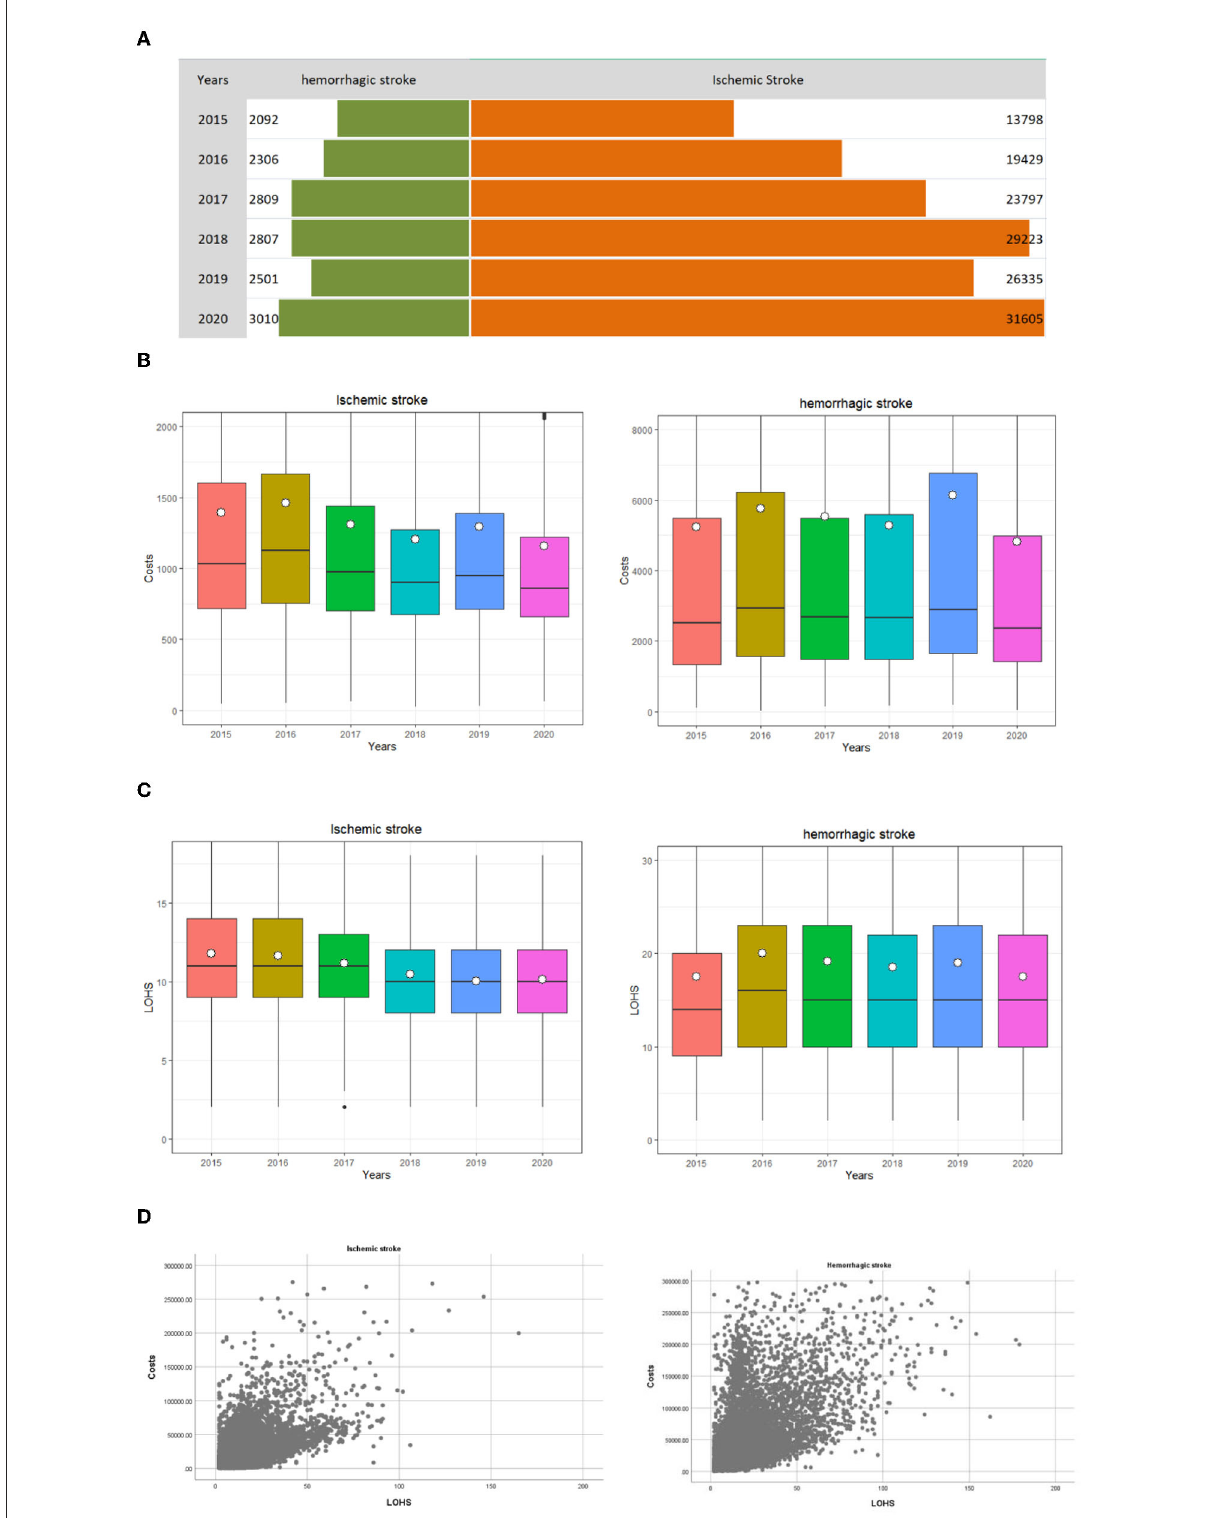
FIGURE1 Distribution of inpatients with stroke discharged from 2015 to 2020 in Ningxia, China. The white dots is the per capita expense, and the middle black line of the box plot represents the median, the bottom line of the box plot represents the lower quartile (the first quartile, Q1),